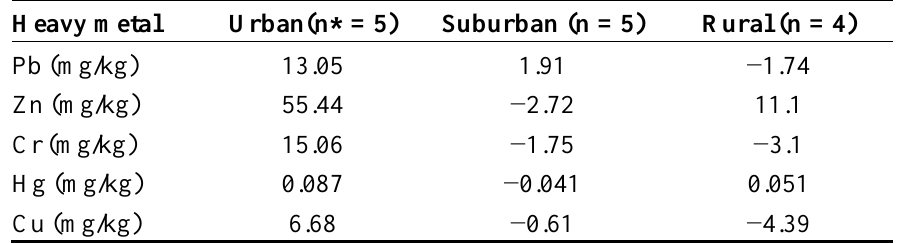
Table 2. Significance test (ANOVA) of subtracted results along with the